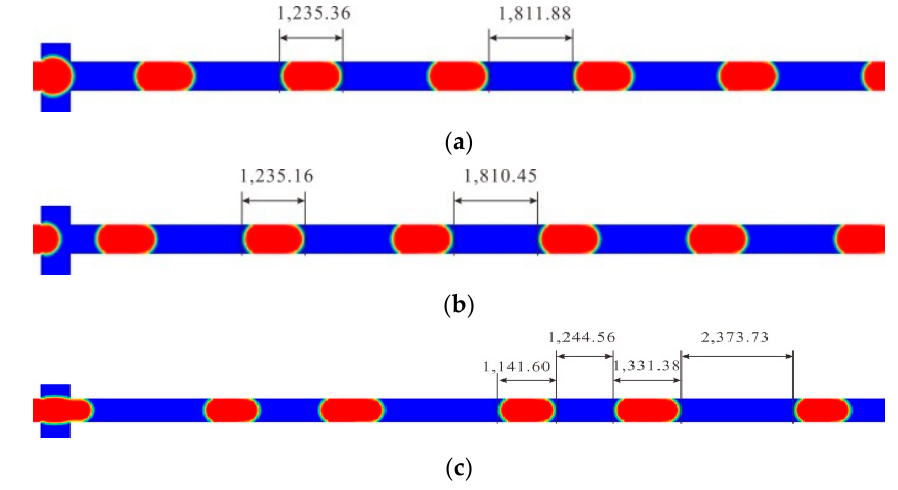
Figure 6. Flow types obtained from numerical simulations for triangle wave dynamic dispersed phase injection flow rate ( μ m). ( a ) The flow type for the condition of triangle wave dynamic dispersed phase injection flow rate with a cycle of 0.5 t 0 ; ( b ) The flow type for the condition of triangle wave dynamic dispersed phase injection flow rate with a cycle of t 0 ; ( c ) The flow type for the condition of triangle wave dynamic dispersed phase injection flow rate with a cycle of 2 t 0